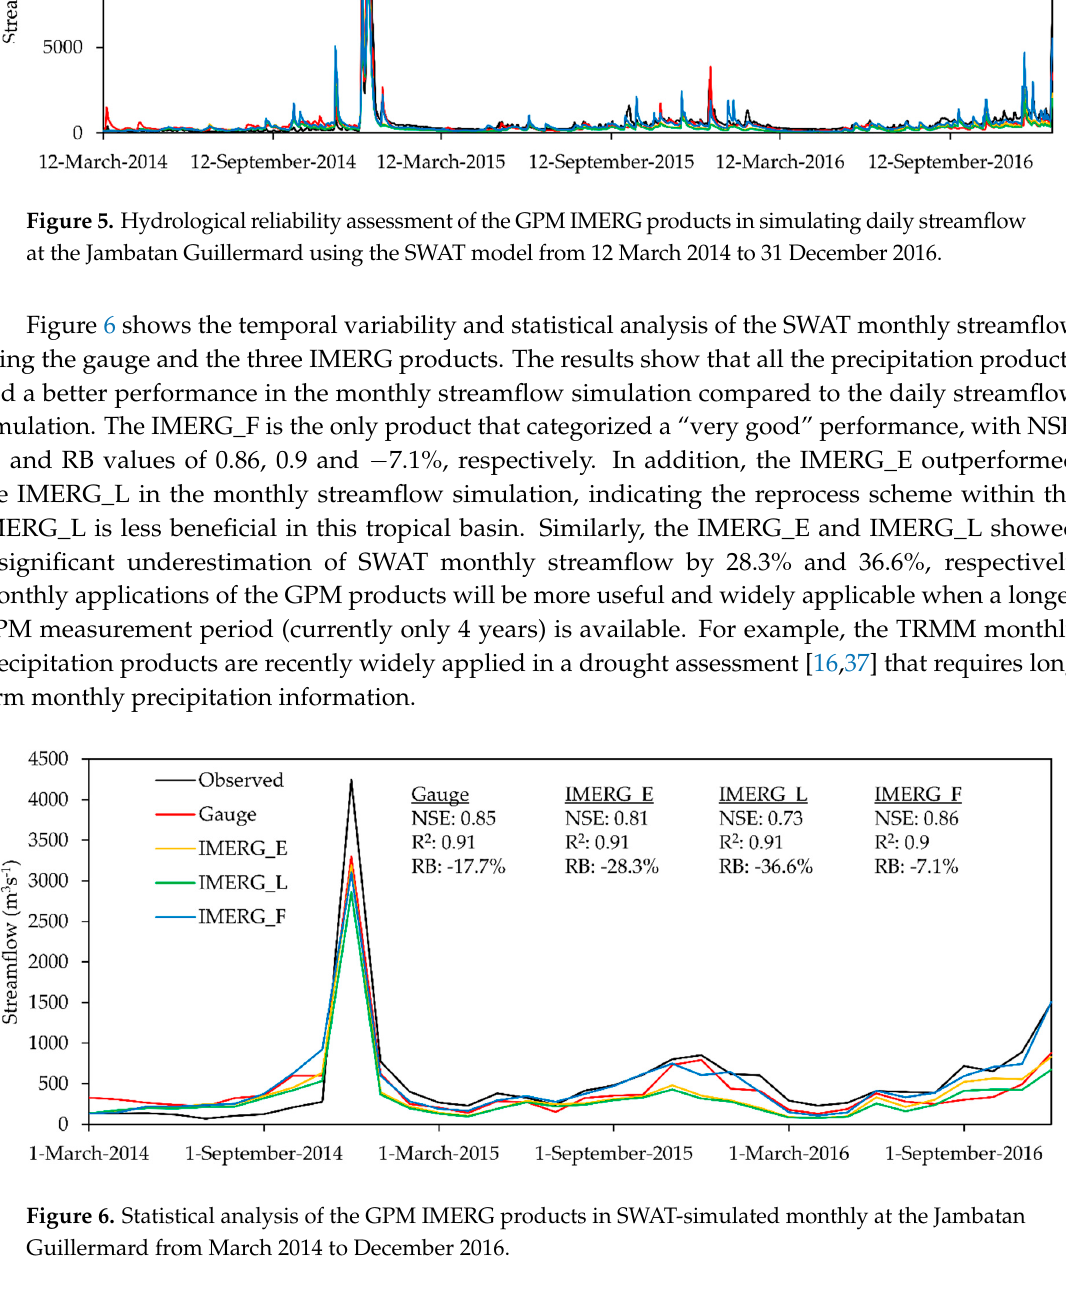
Figure 7. Comparison of cumulative streamflow simulated by the IMERG products and gauge at the Jambatan Guillermard from 12 March 2014 to 31 December 2016. 4.4. The 2014–2015 Flood Assessment